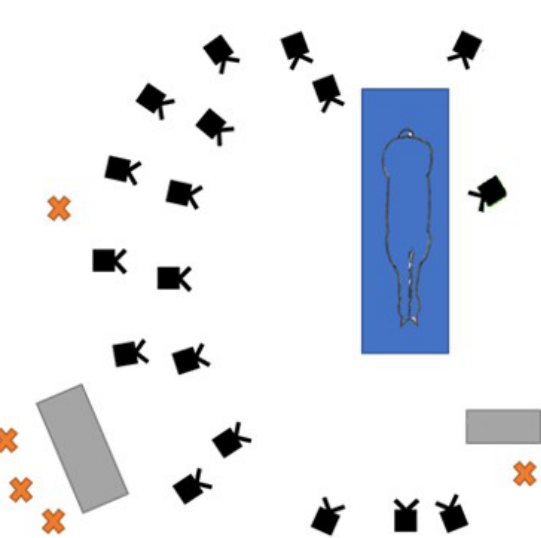
Figure 2. Positioning of Vicon cameras (in black) around the treadmill (in blue) to record the locomotion of the limbs of the right side of the horses. The orange crosses represent the different experimenters and their control tables (computers with software for MoCap and IMUs and treadmill control panel) are shown in gray.